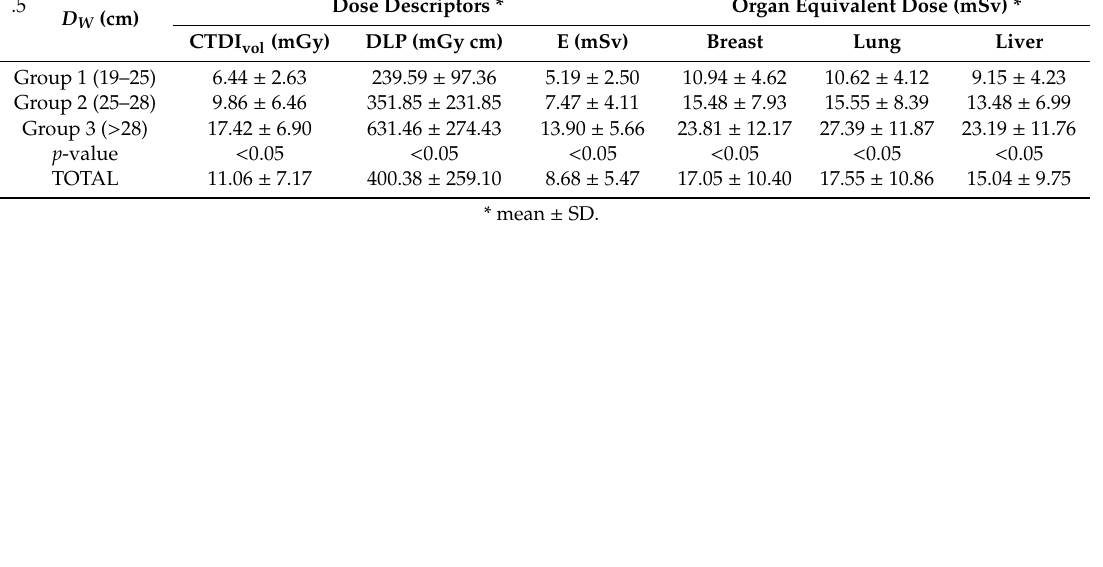
Table 2. Overview of the CTDI vol , DLP, E, and organ dose values from a di ff erent subject group (cid:48) s D W .